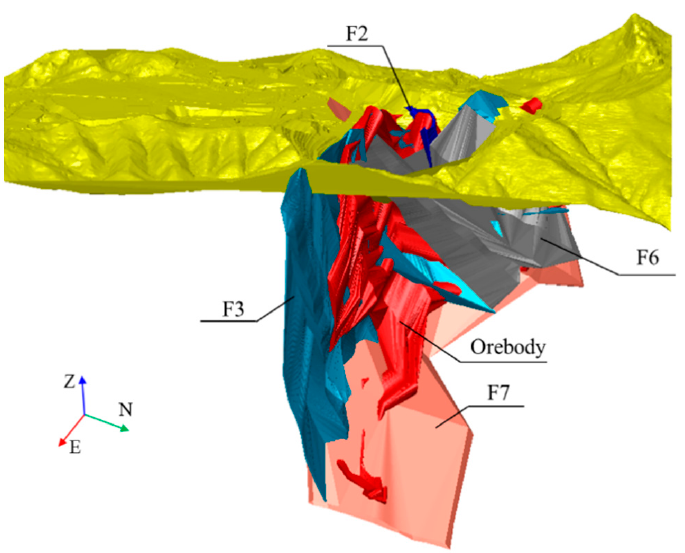
Figure 2. Geological model of Jinfeng Gold Mine (Including faults, ore body and surface topogra- phy).